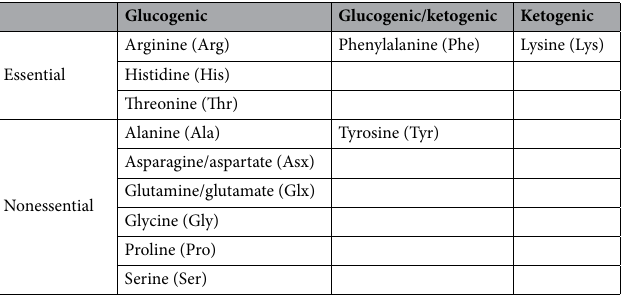
Table 1. Classification of analyzed AAs in fish into essential/non-essential and glucogenic/ketogenic. Abbreviations are given in brackets. Adapted from Falco et al. (2020) 72